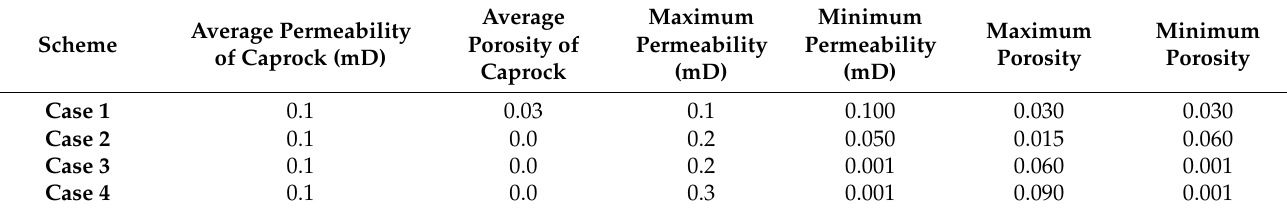
Table 4. Four cases’ parameter